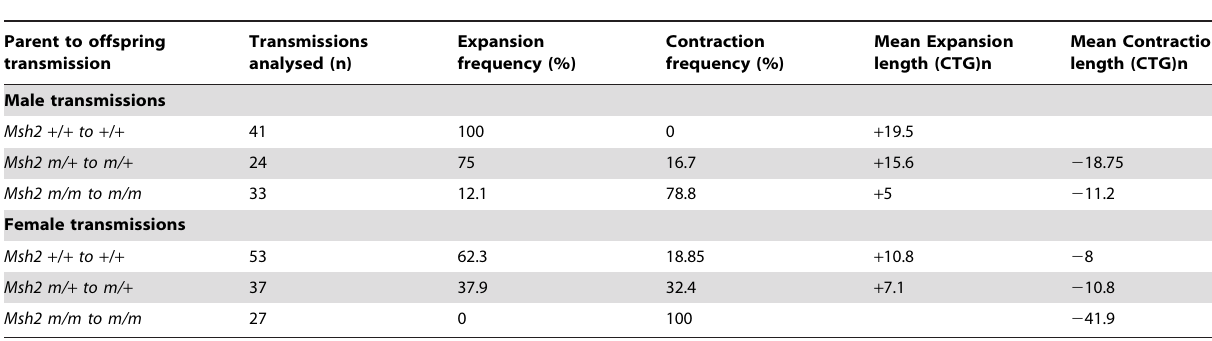
Table 1. Intergenerational CTG repeat instability in transgenic mice carrying the G674A Msh2